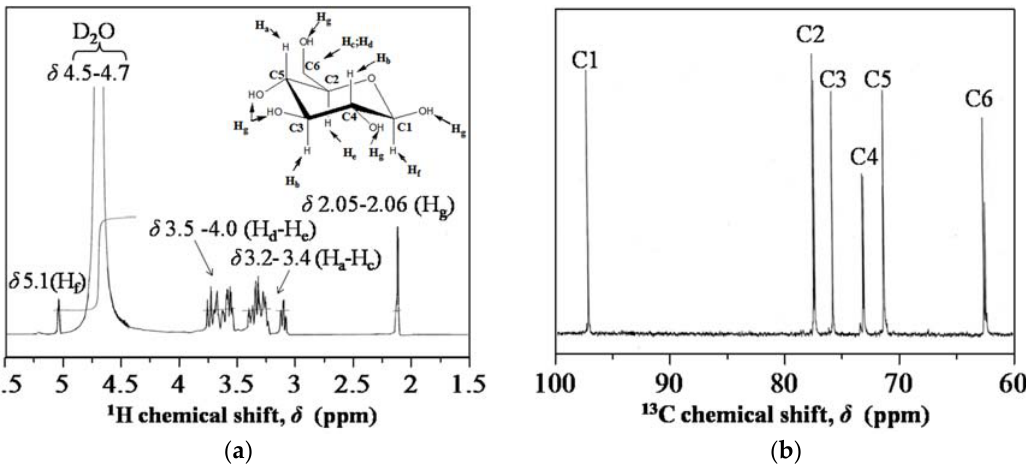
Figure 2. Chemical shifts of hydrolysis of rice starch (HRS) ( a ) proton nuclear magnetic resonance ( 1 H ‐ NMR). Inset shows the representative structures of D ‐ glucose; ( b ) carbon nuclear magnetic resonance ( 13 C ‐ NMR).